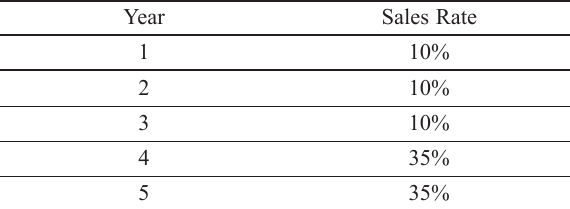
Table 2. Sales rate for each